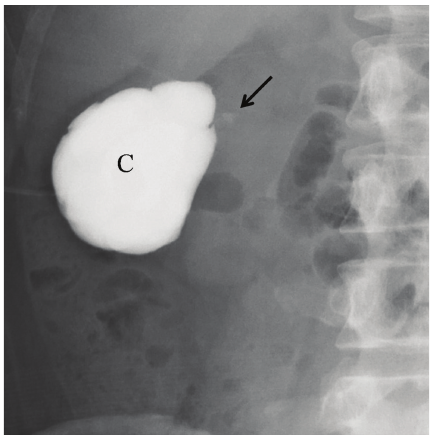
Figure 3: Anterograde pyelography demonstrating communication between the cystic mass and the collecting system (arrow). C, cystic